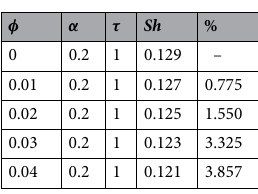
Table 3. Variation in Sherwood number in response to volume fraction of gold